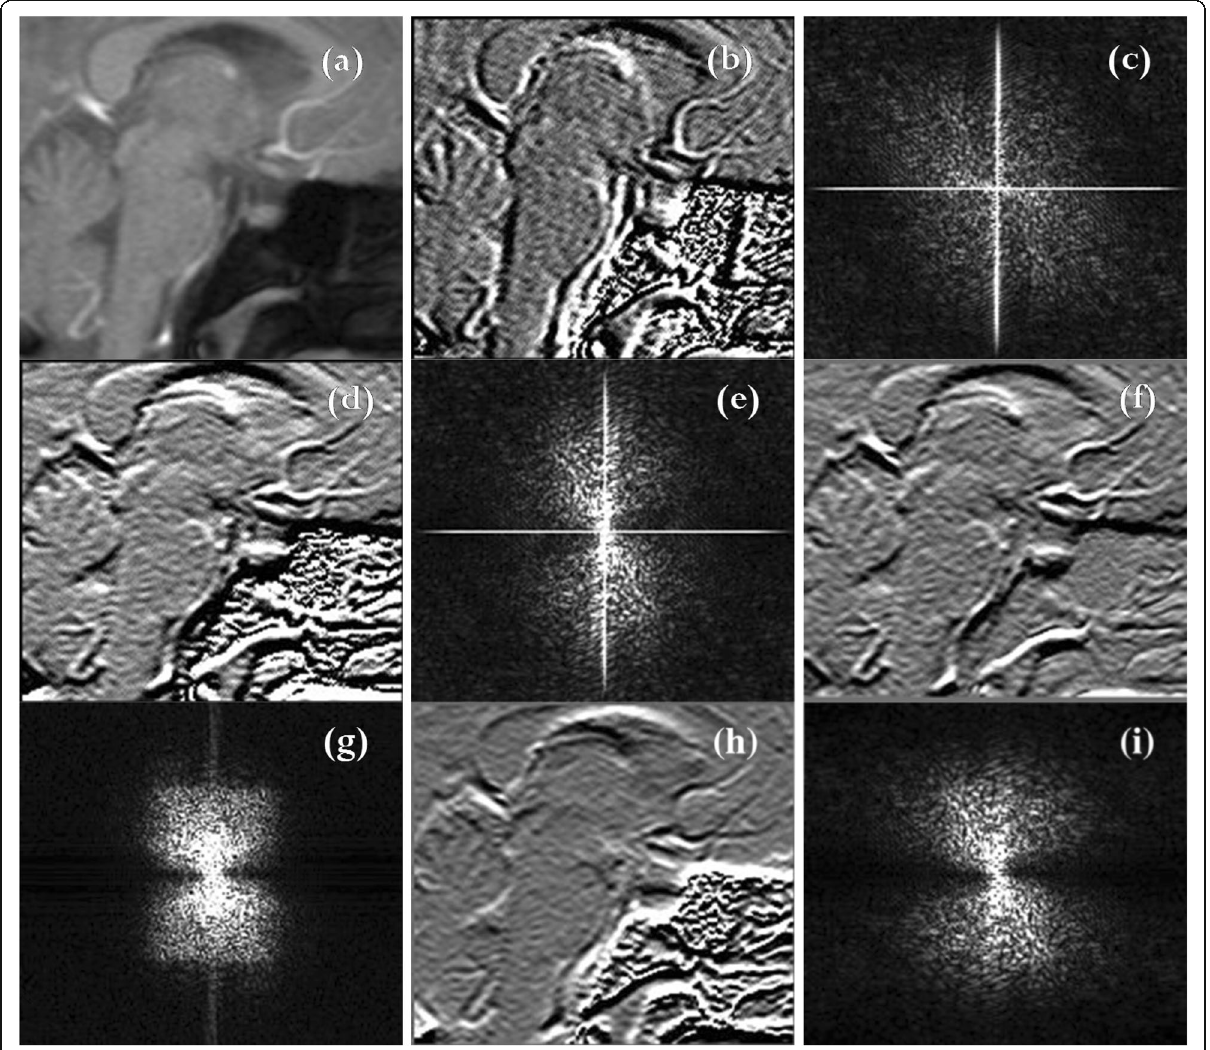
Fig. 7 Comparison across ICF-based HPFs and traditional HPFs. ( a ) MRI. ( b ) MRI filtered with bivariate cubic polynomial model function B32D ICF-based HPF. ( c ) The k-space magnitude of ( b ). ( d ) MRI filtered with the bivariate cubic Lagrange polynomial model function G42D ICF-based HPF. ( e ) The k-space magnitude of ( d ). ( f ) MRI filtered with traditional HPF. ( g ) The k-space of ( f ). ( h ) MRI filtered with the bivariate cubic B-spline H42D ICF-based HPF. ( i ) The k-space magnitude of ( h